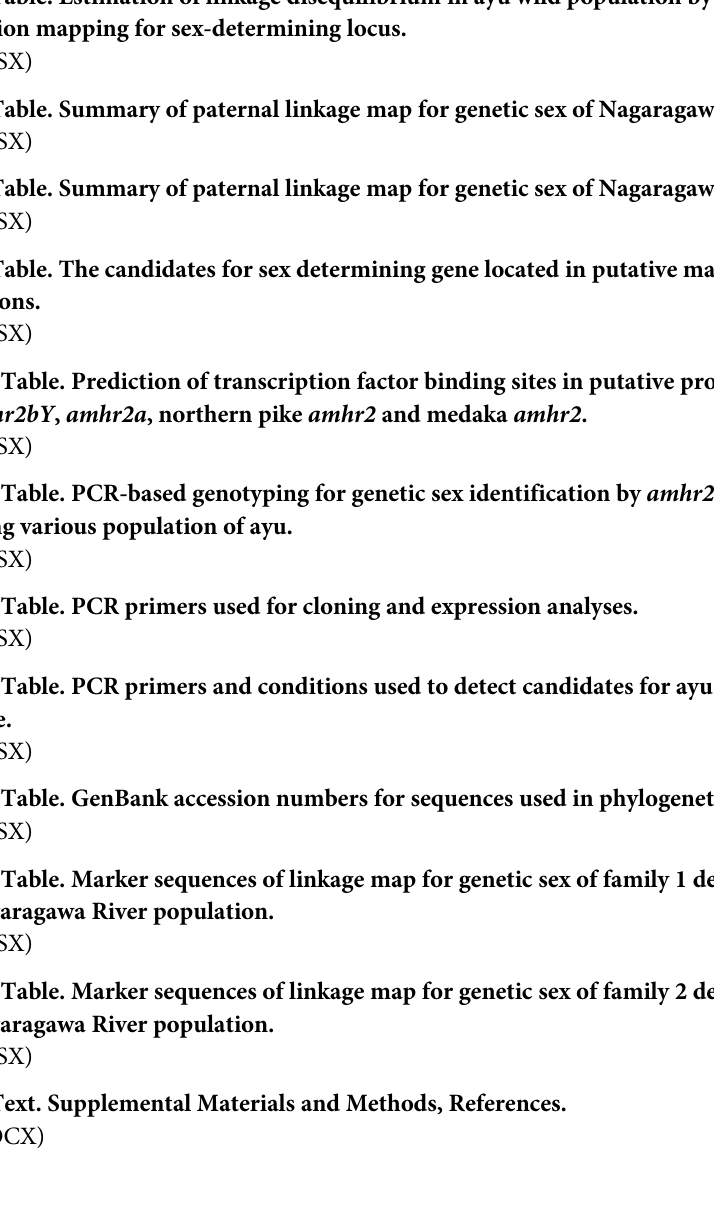
S4 Table. Summary for de novo gene prediction by Augustus. S5 Table. Whole-genome resequencing results. S6 Table. Estimation of linkage disequilibrium in ayu wild population by SNPs using asso- ciation mapping for sex-determining locus. S7 Table. Summary of paternal linkage map for genetic sex of Nagaragawa River family 1. S8 Table. Summary of paternal linkage map for genetic sex of Nagaragawa River family 2. S9 Table. The candidates for sex determining gene located in putative male specific regions. S10 Table. Prediction of transcription factor binding sites in putative promoter regions of amhr2bY , amhr2a , northern pike amhr2 and medaka amhr2 . S11 Table. PCR-based genotyping for genetic sex identification by amhr2bY and amhr2a using various population of ayu. S12 Table. PCR primers used for cloning and expression analyses. S13 Table. PCR primers and conditions used to detect candidates for ayu sex-determining gene. S14 Table. GenBank accession numbers for sequences used in phylogenetic analysis. S15 Table. Marker sequences of linkage map for genetic sex of family 1 derived from Nagaragawa River population. S16 Table. Marker sequences of linkage map for genetic sex of family 2 derived from Nagaragawa River